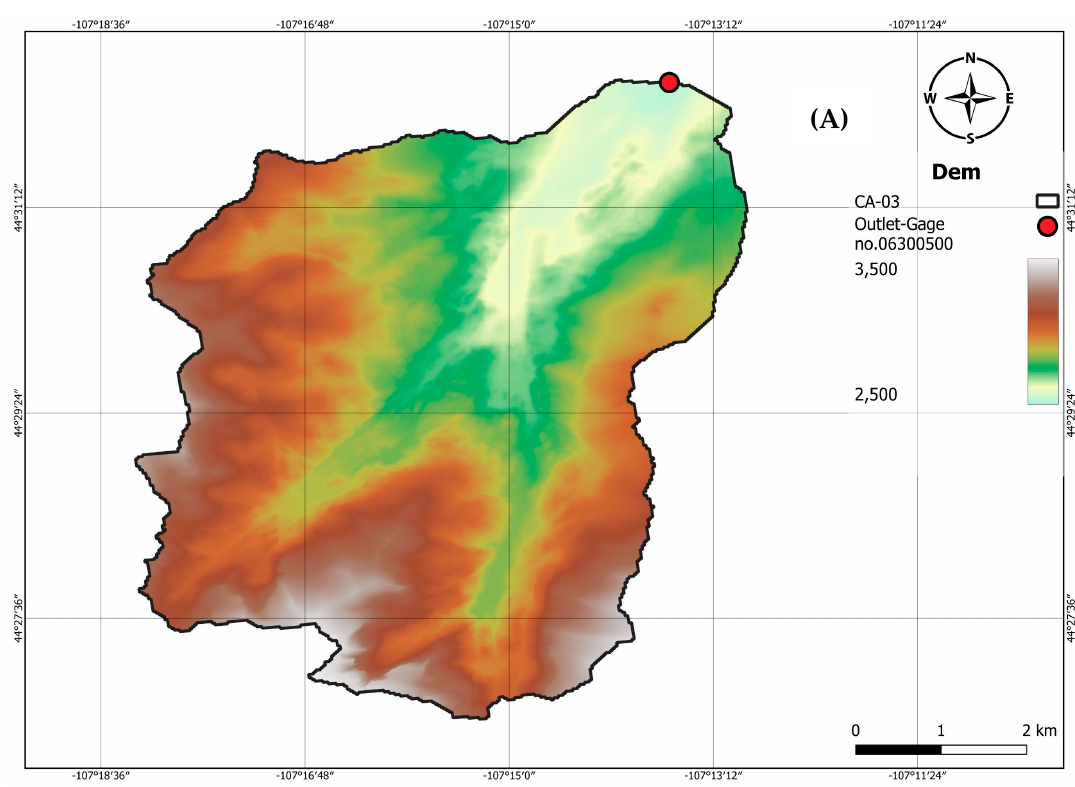
Figure A2. DEM and land-use maps for Catchment CA-02 ( A ) DEM, ( B ) NLCD 2019 land-use map, ( C ) LULC 2020-ESRI land-use map.